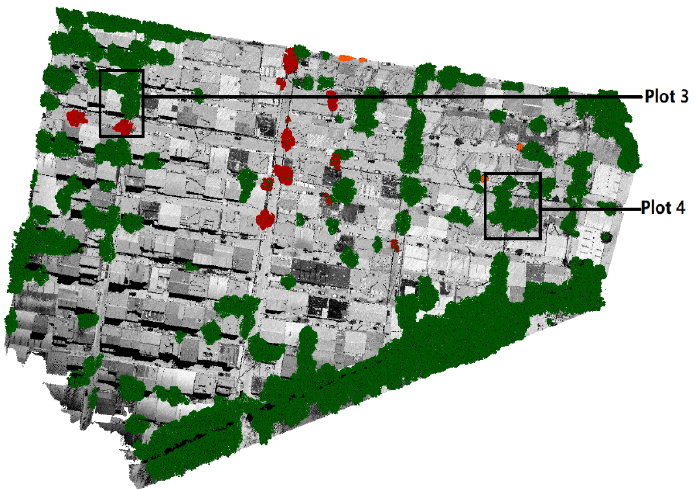
Figure 10. Tree point extraction results of the UAV LiDAR data. Most of the trees are successfully extracted (green points). One incomplete tree at the edges of the data and two trees with small canopies are missed in the extraction (orange points). The mis-extractions (red points) are mainly cluttered and overhanging wires. Table 3. Confusion matrix for UAV LiDAR data extraction results.